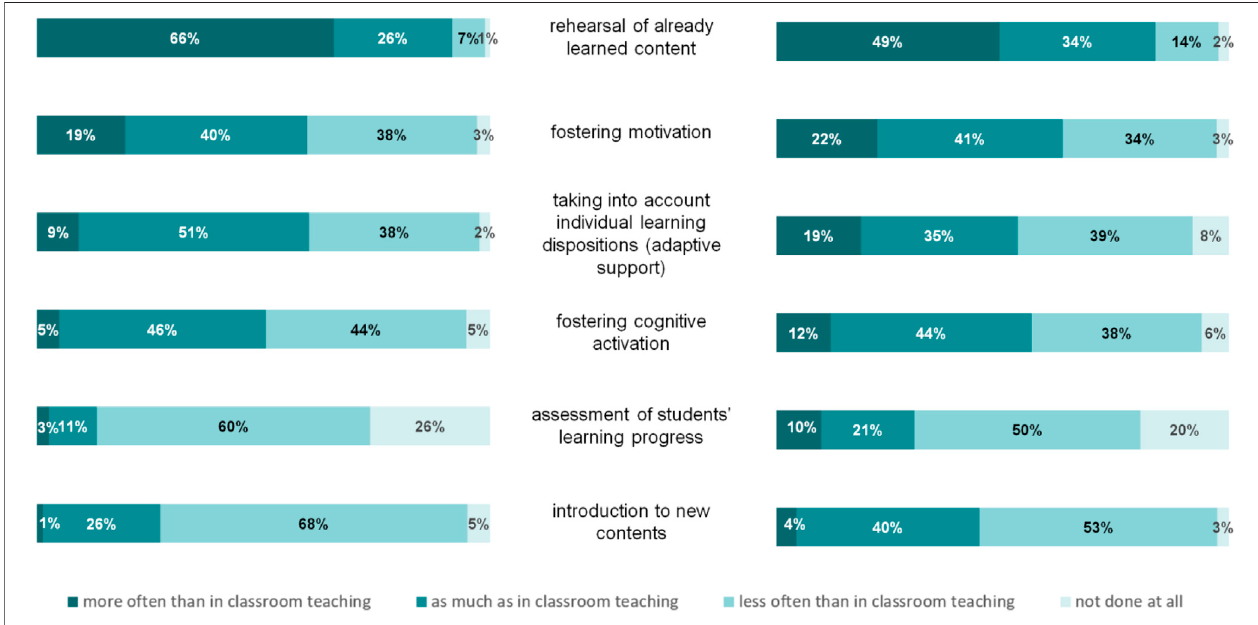
FIGURE 2 | Focus of work assignments and learning materials during distance teaching in comparison to regular classroom teaching.